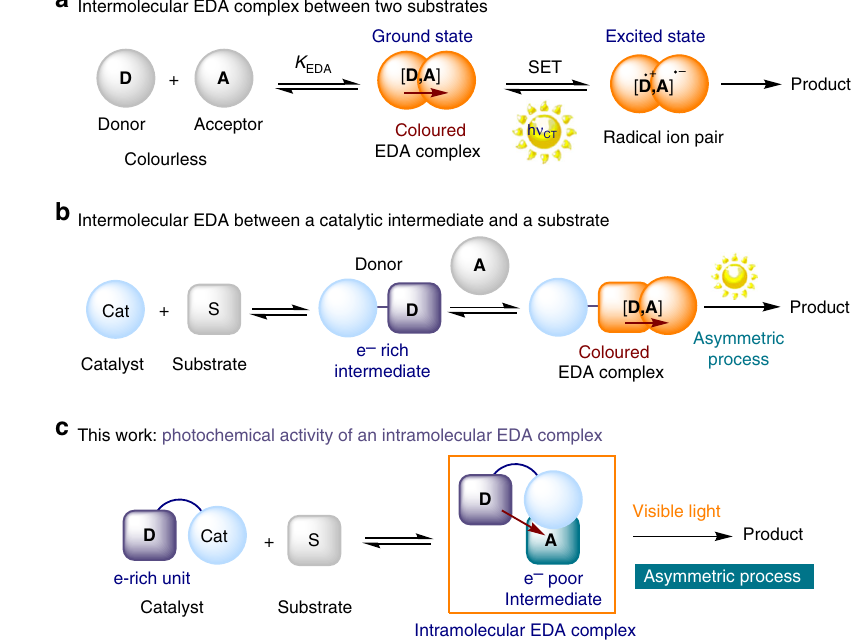
Fig. 1 The EDA complex activation strategy for photochemical synthetic applications. a The principles of EDA complex activation and synthetic use enabled by light. b In situ generated catalytic intermediates can form an intermolecular EDA complex with a substrate. c A catalyst, adorned with an electron-rich unit, reacts with a substrate to generate an electron-poor intermediate prone to intramolecular EDA complex formation. K EDA association constant of EDA complex formation, D electron-rich molecule, A electron-poor molecule, SET single-electron